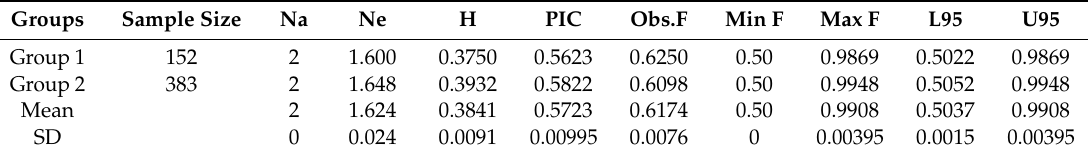
Table 3. Population Genetic Analysis of α -LA Protein Genes (1847th) in Chinese Holstein Dairy Cows. Groups